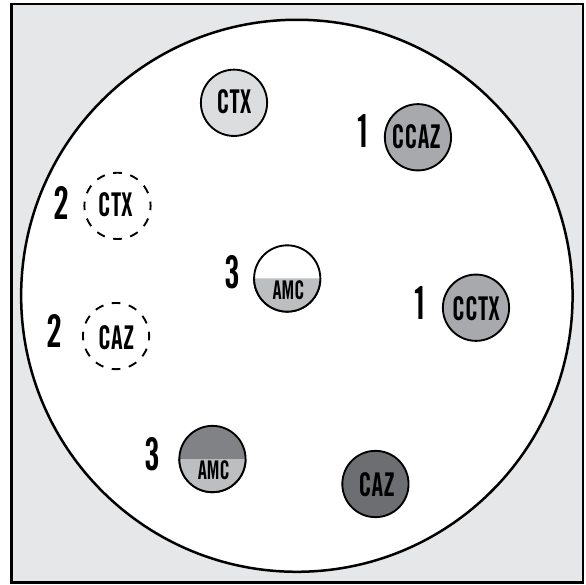
Figura – Representação esquemática da disposição dos discos para os testes de disco combinado (1), substituição de discos (2) e meio disco (3) em placa de ágar Müeller-Hinton (150 mm × 15 mm) CCAZ: ceftazidima + ácido clavulânico; CCTX: cefotaxima + ácido clavulânico; CTX: cefotaxima; CAZ: ceftazidima; AMC: amoxicilina + ácido